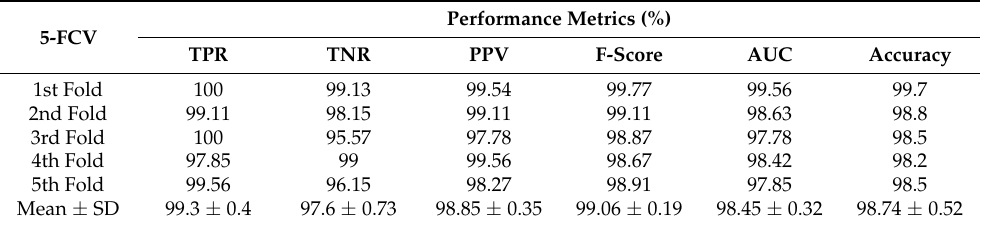
Table 5. Classification performance of the proposed model on SGDM optimizer.